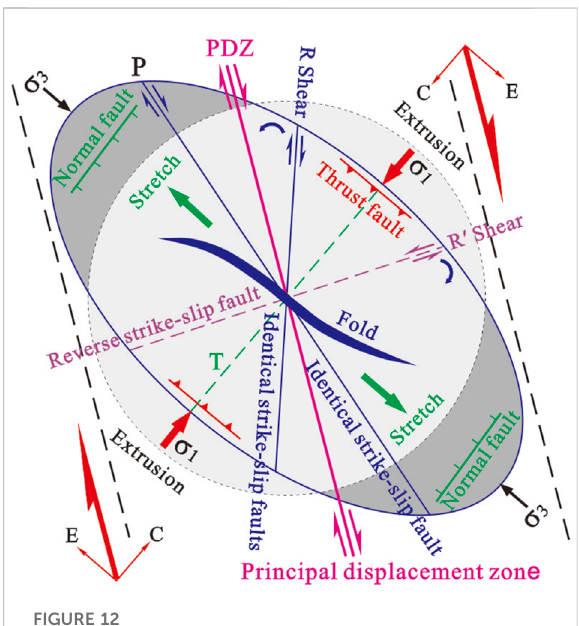
FIGURE 12 Illustration of the Riedel shear mode of the right strike-slip fault (Harding, 1974). *C, compression vector; E, extension vector; R, Riedel shear or same-directional strike-slip fault; R ′ , conjugate Riedel shear or reverse strike-slip fault; P, same-directional shear or secondary same-direction fault; T, local extension with shear; σ 1 , maximum principal stress with a N-E direction; σ 2 , intermediate principal stress with a vertical direction; σ 3 , minimum principal stress with a N-W